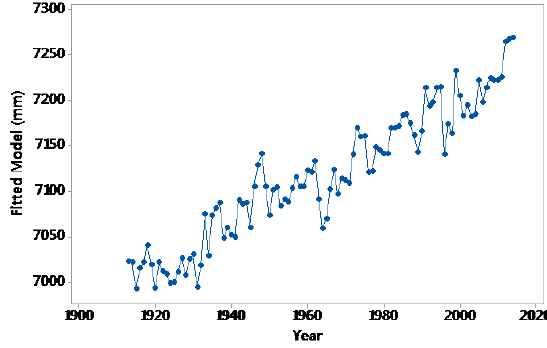
Figure 11: Reconstructed Key West time series using the statistically significant model